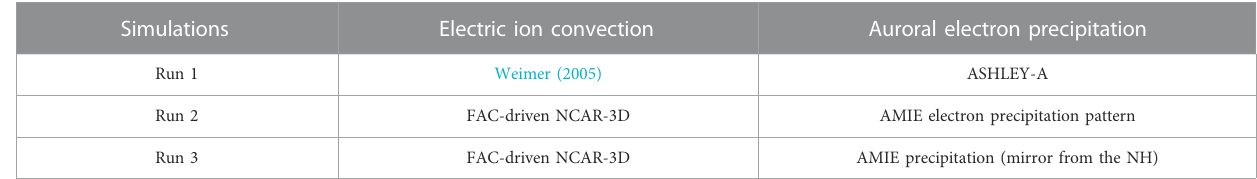
TABLE 1 Summary of simulations conducted in this